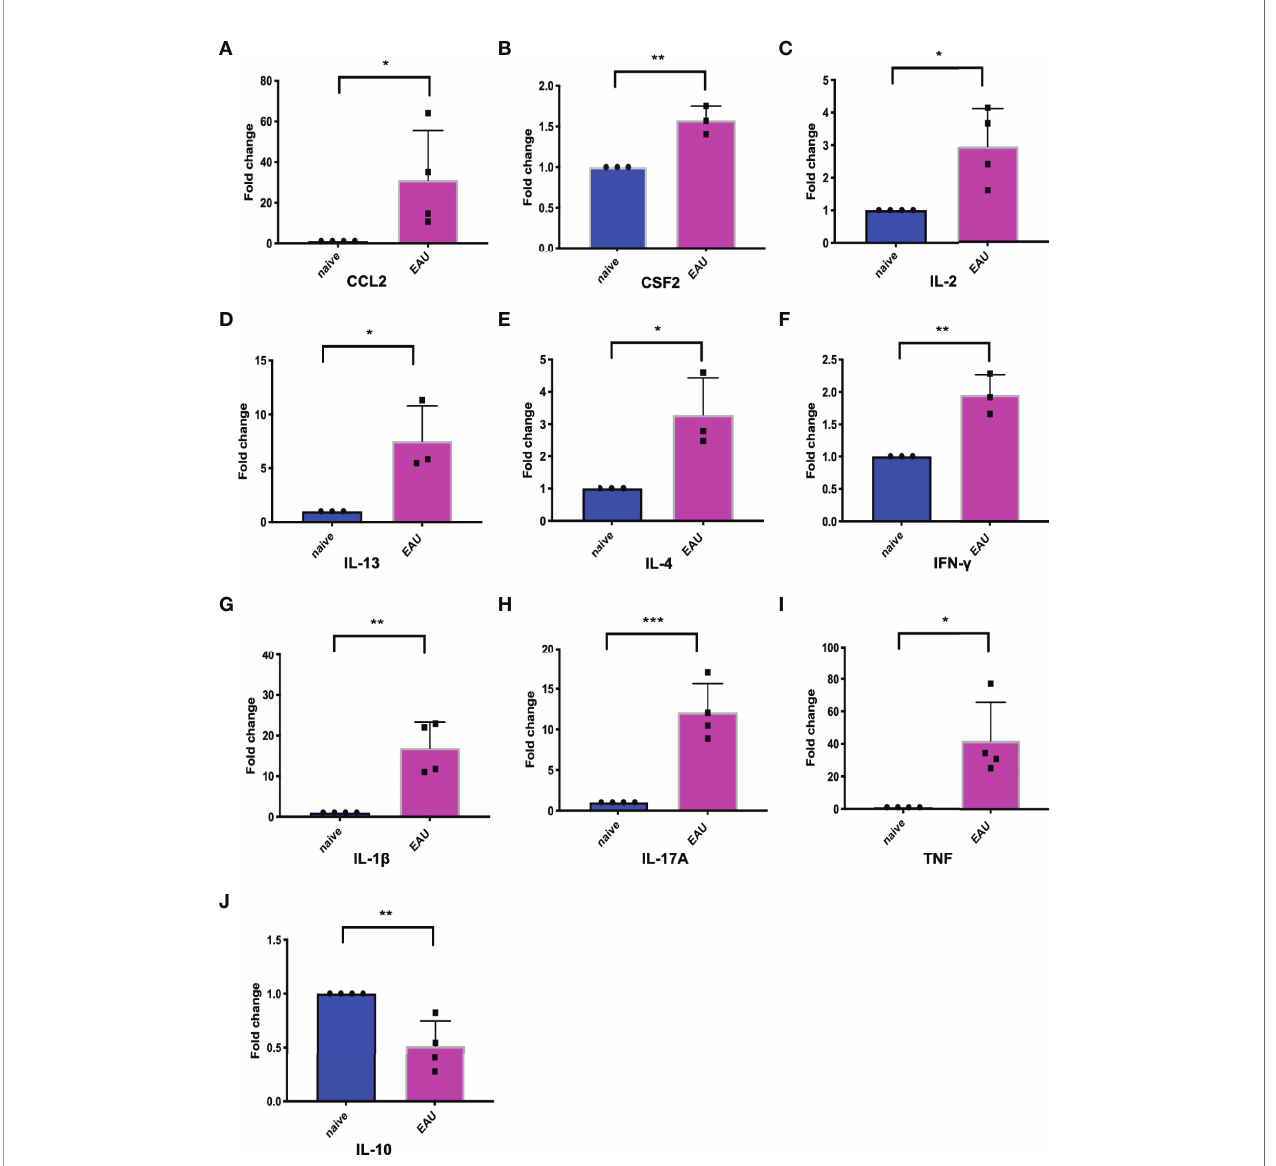
FIGURE 7 | The expression of 10 hub genes in retinas of EAU mice and naive mice. The blue represents naive mice, and the red represents EAU mice. (A-J) represents the expression changes of CCL2, CSF2, IL-2, IL-13, IL-4, IFN- g , IL-1 b , IL-17A, TNF and IL-10, respectively. Except for the decreased expression of IL-10 in EAU, the other 9 hub genes were upregulated in EAU. * P < 0.05; ** P < 0.01; *** P < 0.001 (two-tailed student ’ s t -test). Graphs show mean ±